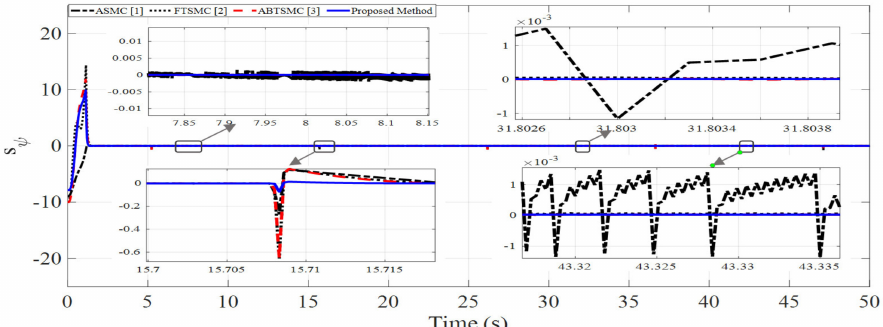
Figure 2. Sliding surface under 40% sinusoidal fault to actuators 2 and 3.